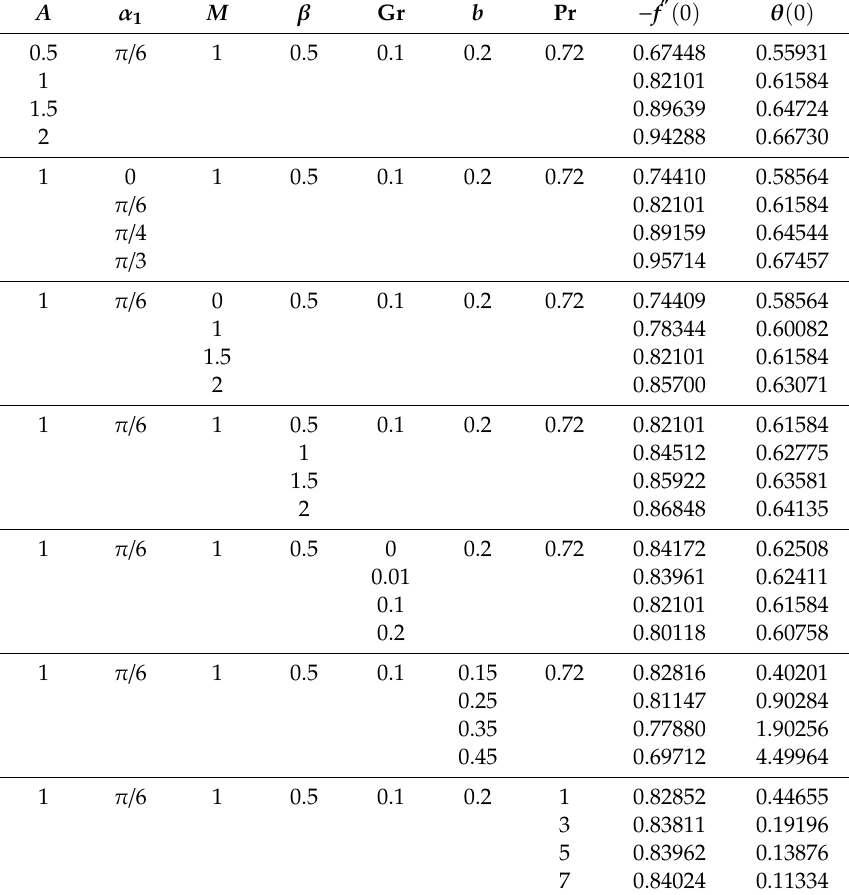
Table 2. Numerical values of − f (cid:48)(cid:48) ( 0 ) and θ ( 0 ) for various values of